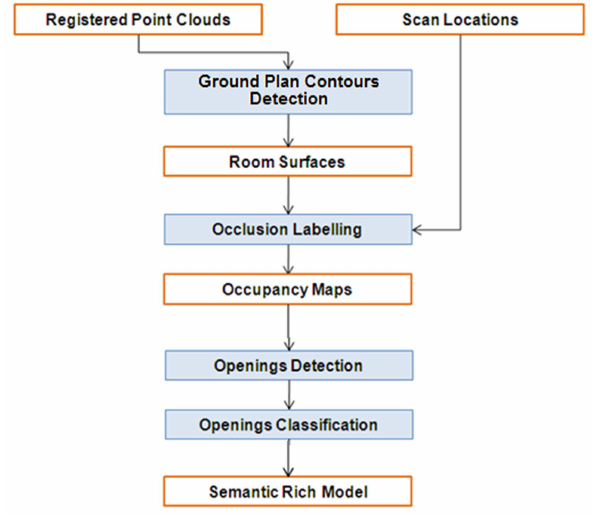
Figure 1. Workflow of the developed methods for automatic indoor modelling (AIR) of building